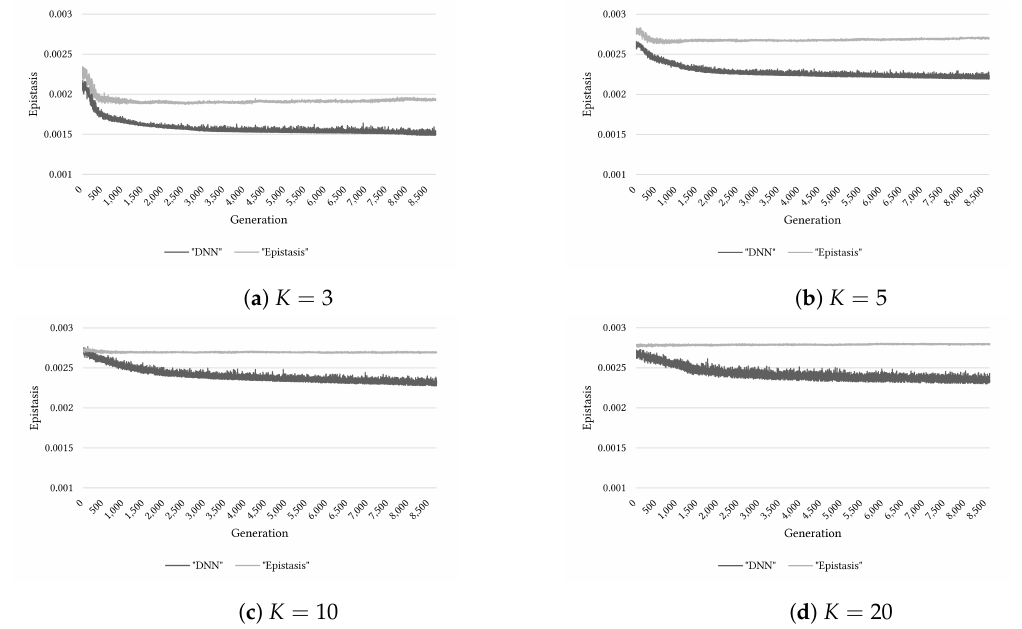
Figure 11. Comparison of target epistasis values (“Epistasis”) and ones estimated by DNN (“DNN”) on the NK -landscape problem ( N =